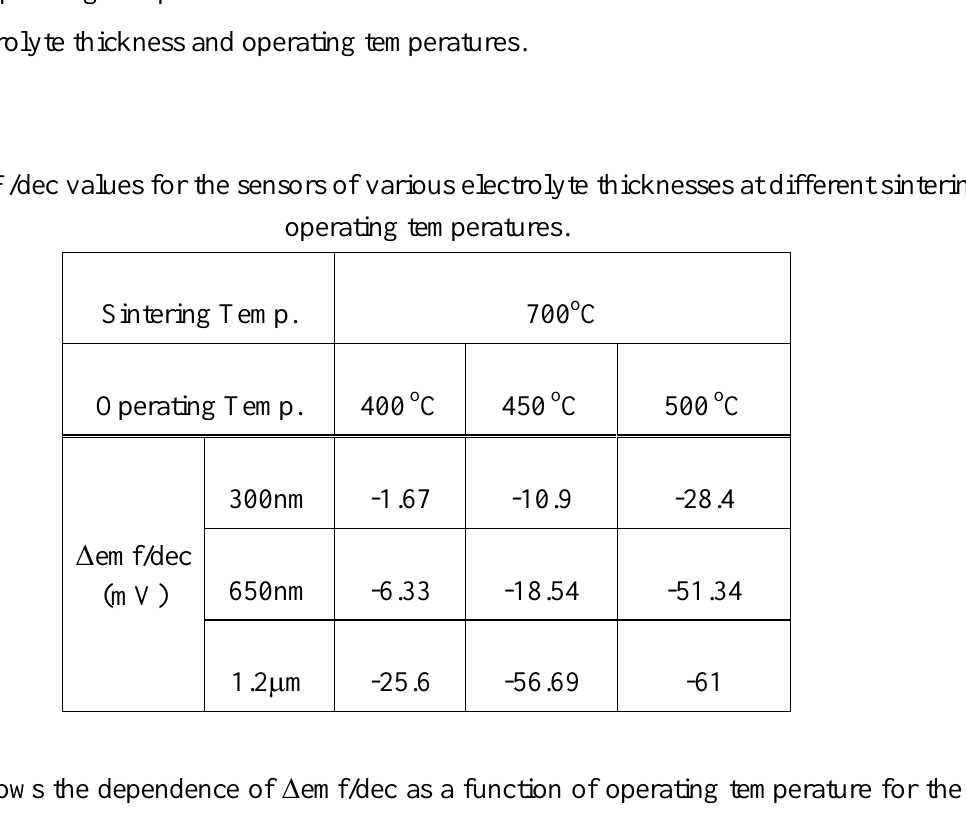
The ∆ emf/dec values obtained for sensors with various electrolyte thicknesses at different sintering and operating temperatures are shown in Table.1. The emf values were increased with increasing electrolyte thickness and operating temperatures.